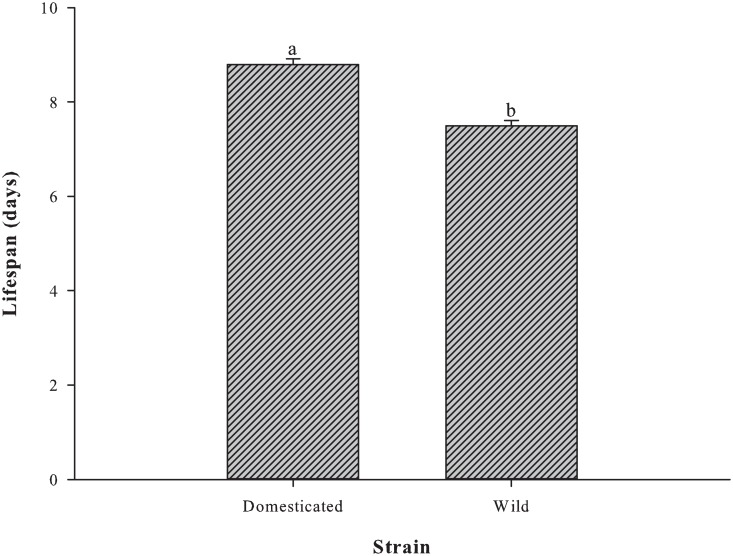
Adult female lifespan of P. crassirostris strains (n = 10).The different letters on the tops of the bars indicate significant differences (p <0.001).